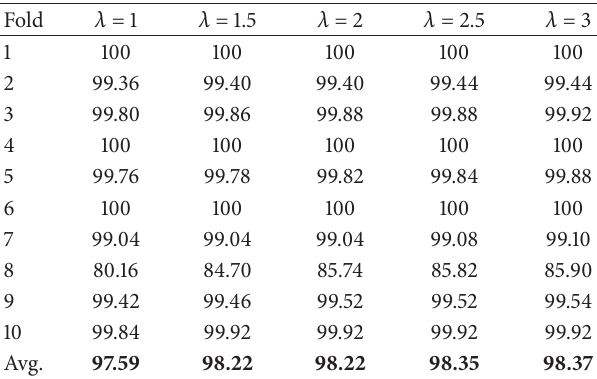
Table 4: Tenfold cross validation results of DoS